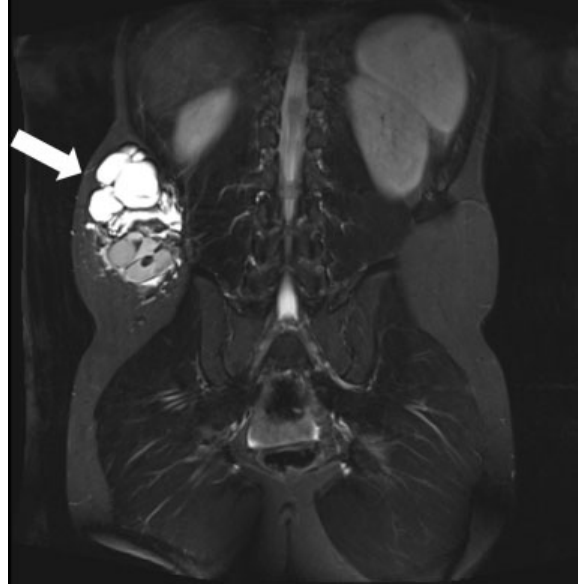
Fig. 1 Coronal T2 magnetic resonance imaging (MRI) with a sub- cutaneous mixed macro-/microcystic lymphatic malformation on the patient ’ s right fl ank (white arrow).